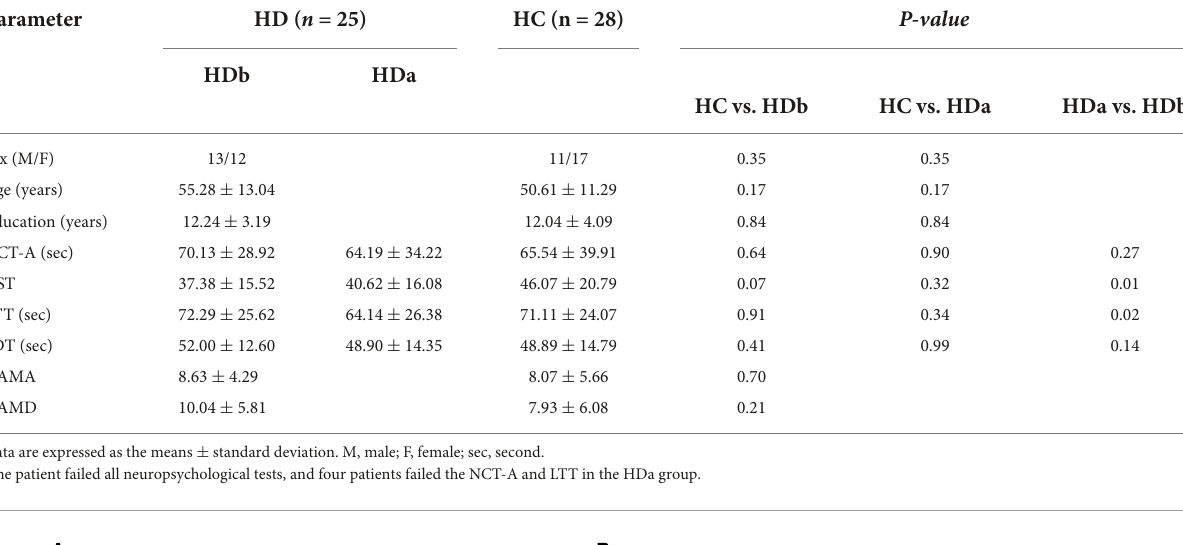
TABLE 1 Demographic and clinical measures.